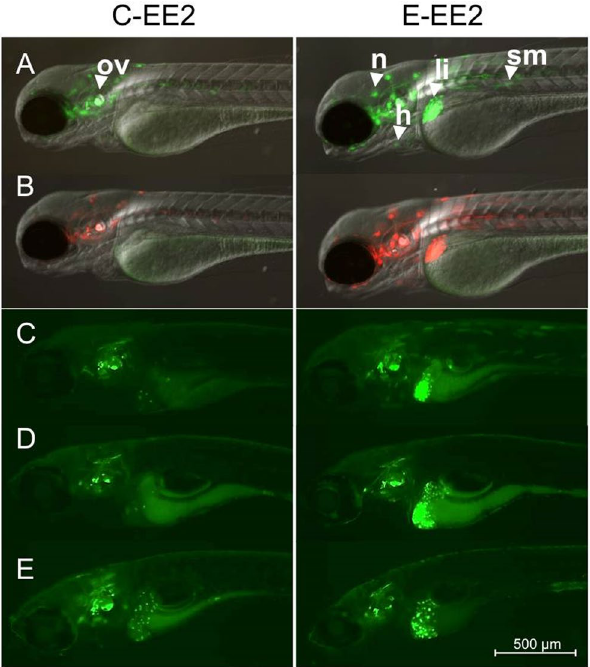
Figure 5. Sensitivity to ethinylestradiol for repeated exposures. Control (non-exposed) larvae and larvae exposed initially to 10 ng EE2/L over the period of 48 h (0–2 dpf) were imaged at 3 dpf ( A ) and the Kaede response was then converted fully from green to red fluorescence via UV exposure ( B ). Both groups of photoconverted larvae (control and EE2-exposed) were then exposed to 10 ng EE2/L over the period 3–5 dpf ( C ), 5–7 dpf ( D ) or 9–11 dpf ( E ) and imaged on the final day of exposure (n = 18). Newly generated Kaede expression (green fluorescence) in liver, heart and somite muscle green was quantified by image analysis. All images were acquired by inverted compound microscope using a 5 × objective. ( A ) and ( B ) images were acquired using GFP, RFP and DIC filters. ( C ), ( D ), and ( E ) are presented with the GFP filter only. Specific tissue response in the liver (li), heart (h), somite muscle (sm), otic vesicle (ov) and neuromast